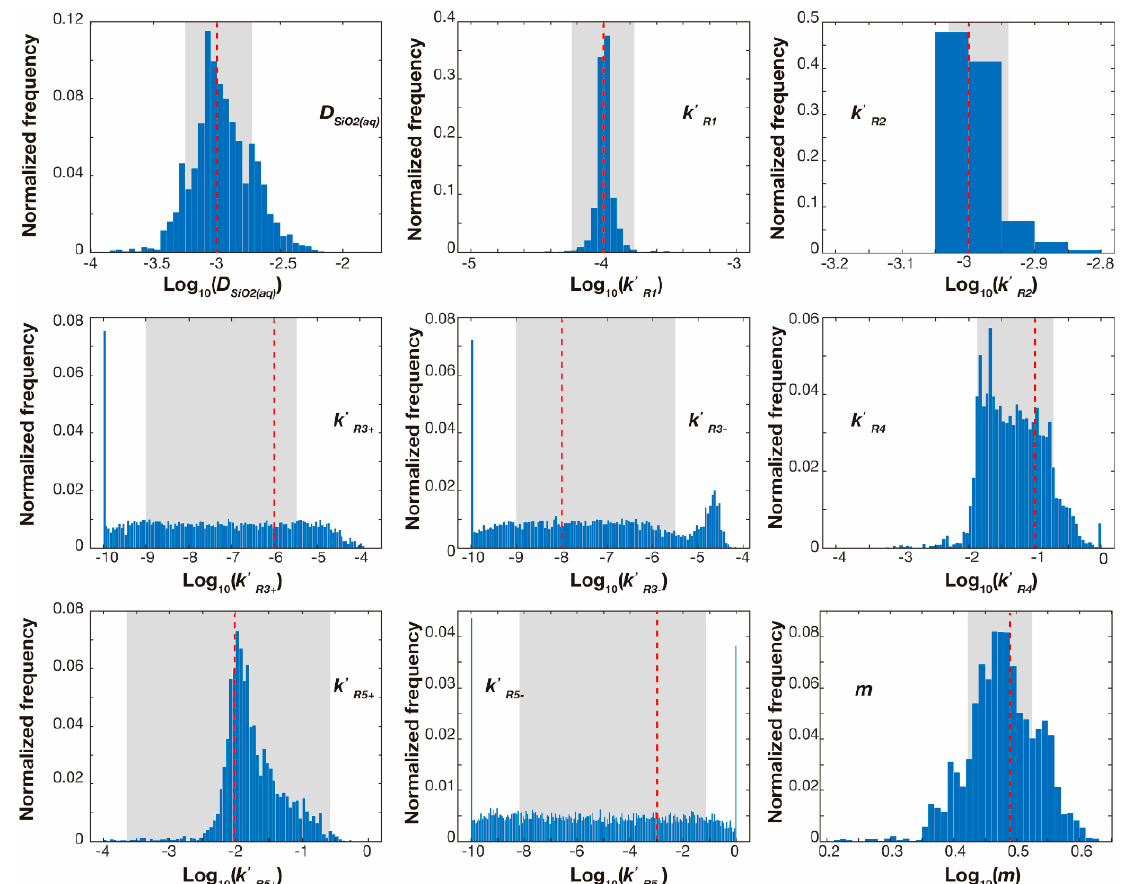
Figure 4. Histograms showing estimated candidate values sampled using the exchange Monte Carlo method from the noisy datasets ( σ y = 10 –1.5 ; Figure 3a–e). Each gray region represents the average ± one standard deviation of the parameters sampled using the EMC method. Dotted red lines show the true values of each parameter described in Section 3. To allow comparison of each parameter, the bin ranges for D SiO2(aq) and k ′ n were uniformly set to 0.05 log units, whereas the range for m was set to 0.01 log units.